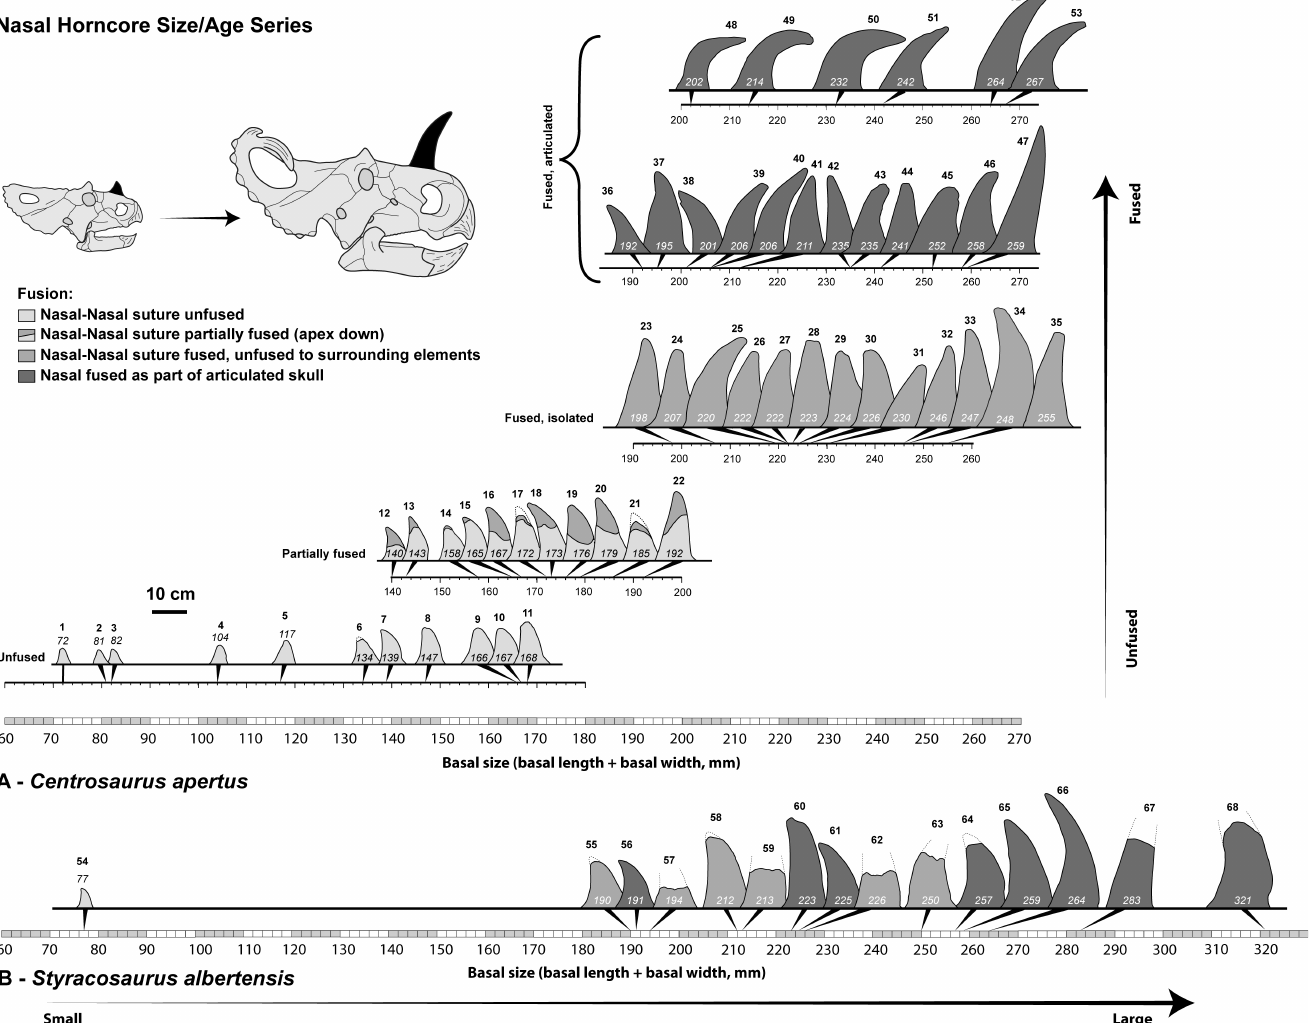
Figure 7. Size series of Centrosaurus apertus (A, upper) and Styracosaurus albertensis (B, lower) nasal horncores in right lat- eral view. Specimens are arranged along the horizontal axis according to their size (basal length plus basal width), and those of Centrosaurus are separated based on their degree of cranial sutural fusion (shaded infill). Although ordered based on size, the absolute position does not correlate directly with size due to spacing constraints. Numbers in italics indicate basal size metric, while numbers in bold refer to specimen numbers listed in Appendix